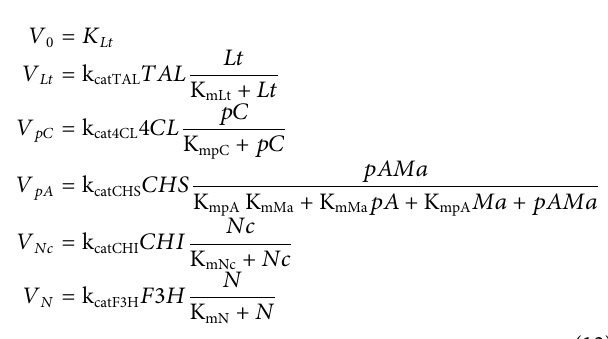
FIGURE3| Dynamicpathwayregulationschemeforthenaringeninpathway.ThetargetmetabolitenaringeninisproducedfromL-tyrosineinfourenzymaticsteps, includingamerging stepcatalysed bytheenzymenaringeninchalcone synthase (CHS)which incorporates thesecondary metabolite malonyl-CoA. Theproductionlevel of naringenin is readout using a metabolic extended TF-based biosensor through the downstream metabolite kaempferol. This is sensed using the QdoR TF-based biosensor and feeds back to an antithetic biomolecular controller. The controller can be activated upstream by means of the external inducer AHL. Its actuating signal overdrives the basal constitutive expression of the CHS enzyme in the pathway in order to compensate for malonyl-CoA